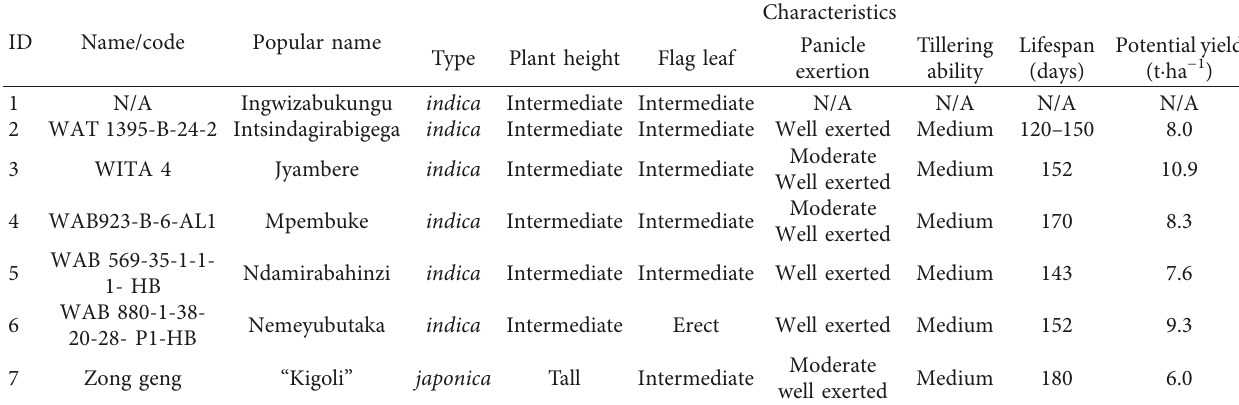
Table 1: Characteristics of 7 Rwandan rice cultivars (ISAR